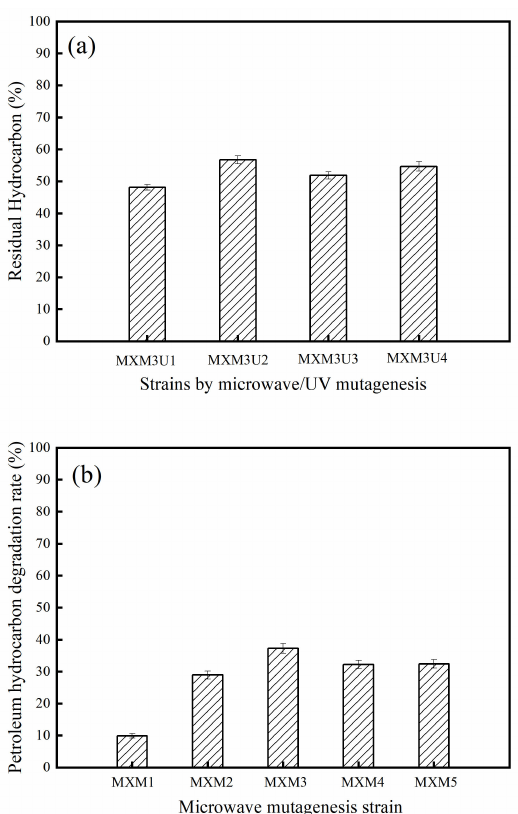
Figure 5. TPHs removal efficiency of strains by UV ( a ) and microwave ( b )